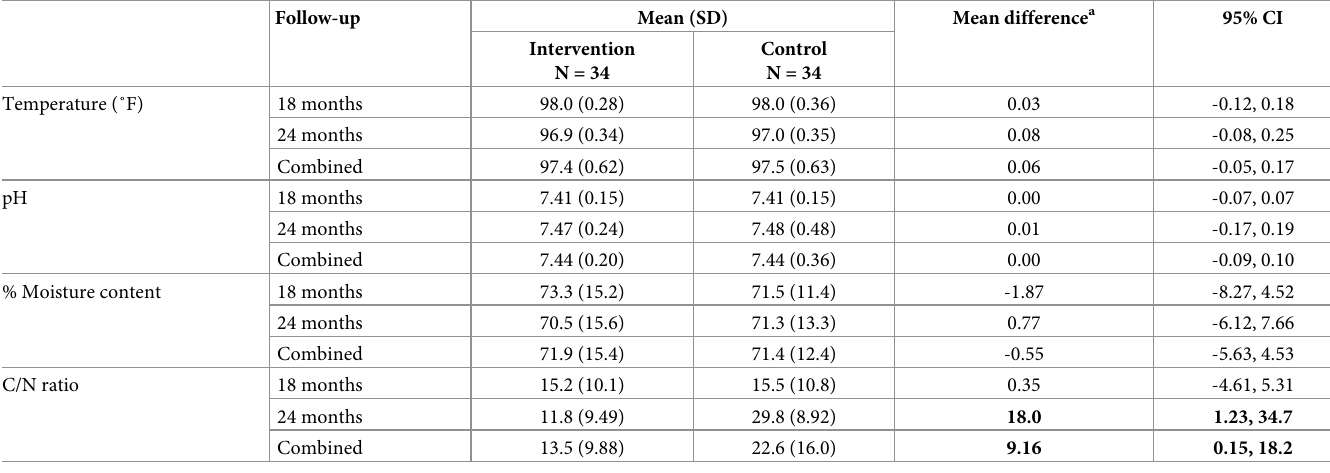
Table 2. Average temperature, pH, percentage of moisture content, and carbon-nitrogen ratio of latrine sludge samples at 18 and 24 months of follow-up. Follow-up